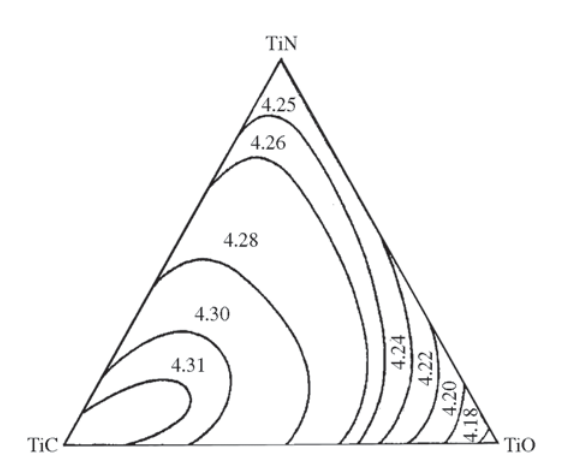
Figure 1. Pseudoternary diagram of the TiN-TiC-TiO system at 1100 °C (from Neumann et al. ) 1 . The cell parameters a Ti(C,N,O) are indicated. The lines separate zones of similar a